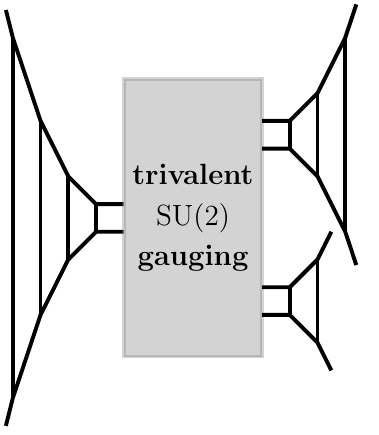
Figure 11 . A web-like of the 5d theory which is dual to the pure E 7 gauge theory.